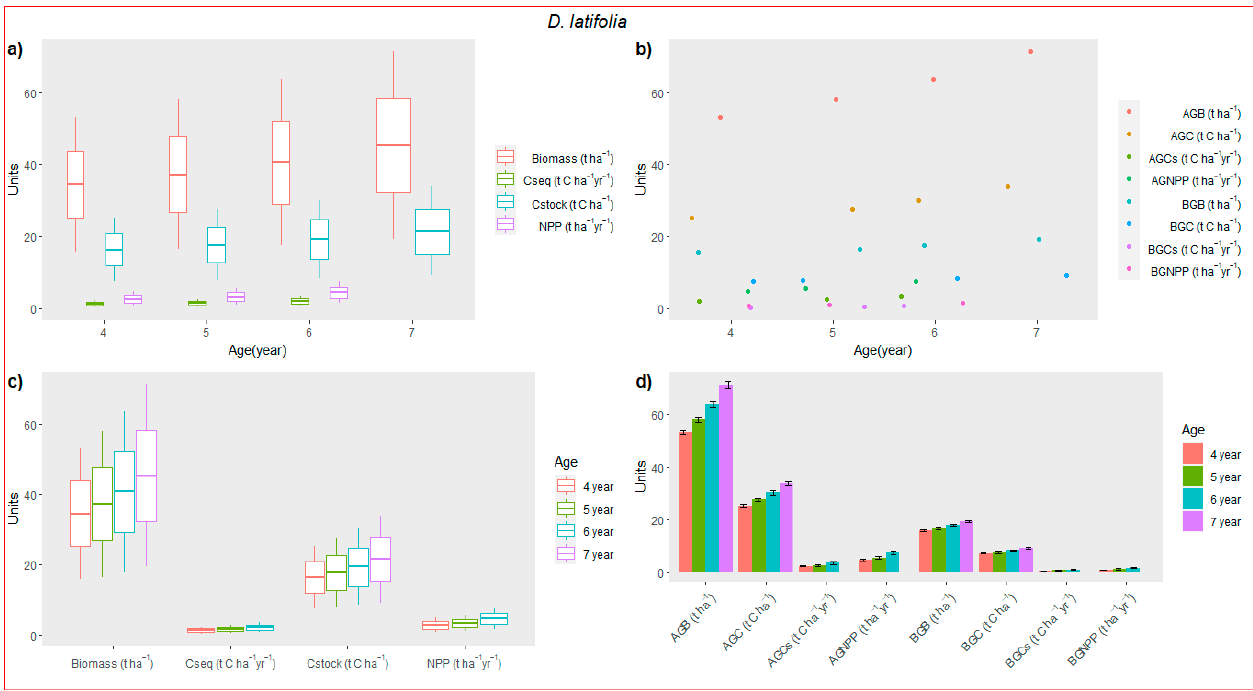
Figure 5. Relationship between tree stand characteristics and age of the stand ( M. composita ).